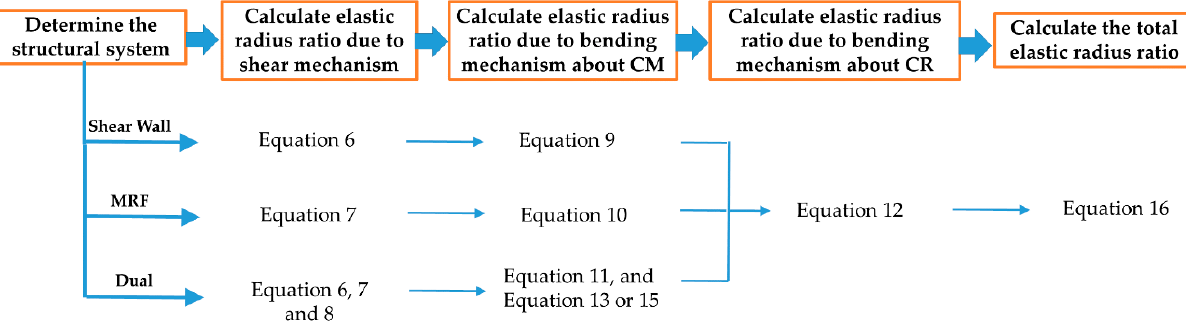
Figure 1. The procedure of determining the elastic radius ratio by the proposed shear and bending combination method (SBCM) method.